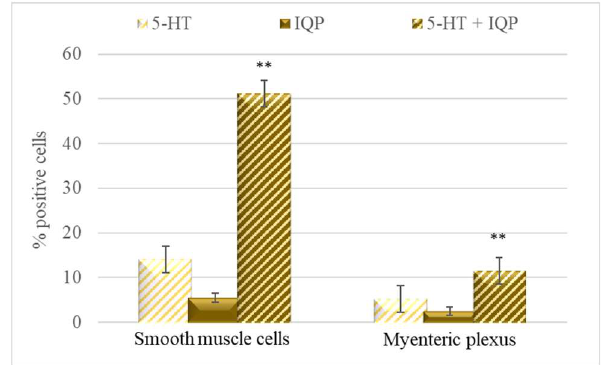
Figure 5. Data from the measurement of the immunoreactivity of nNOS in circular and longitudinal SM cells and the myenteric plexus of the stomach are presented. A t-test was used. ** p <